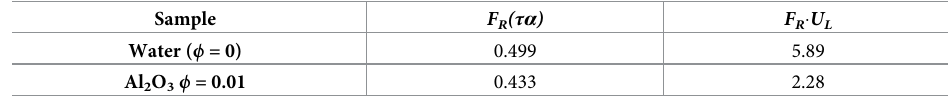
Table 5. F R ( τ α ) and F R � U L parameters at 2.4 l/min.